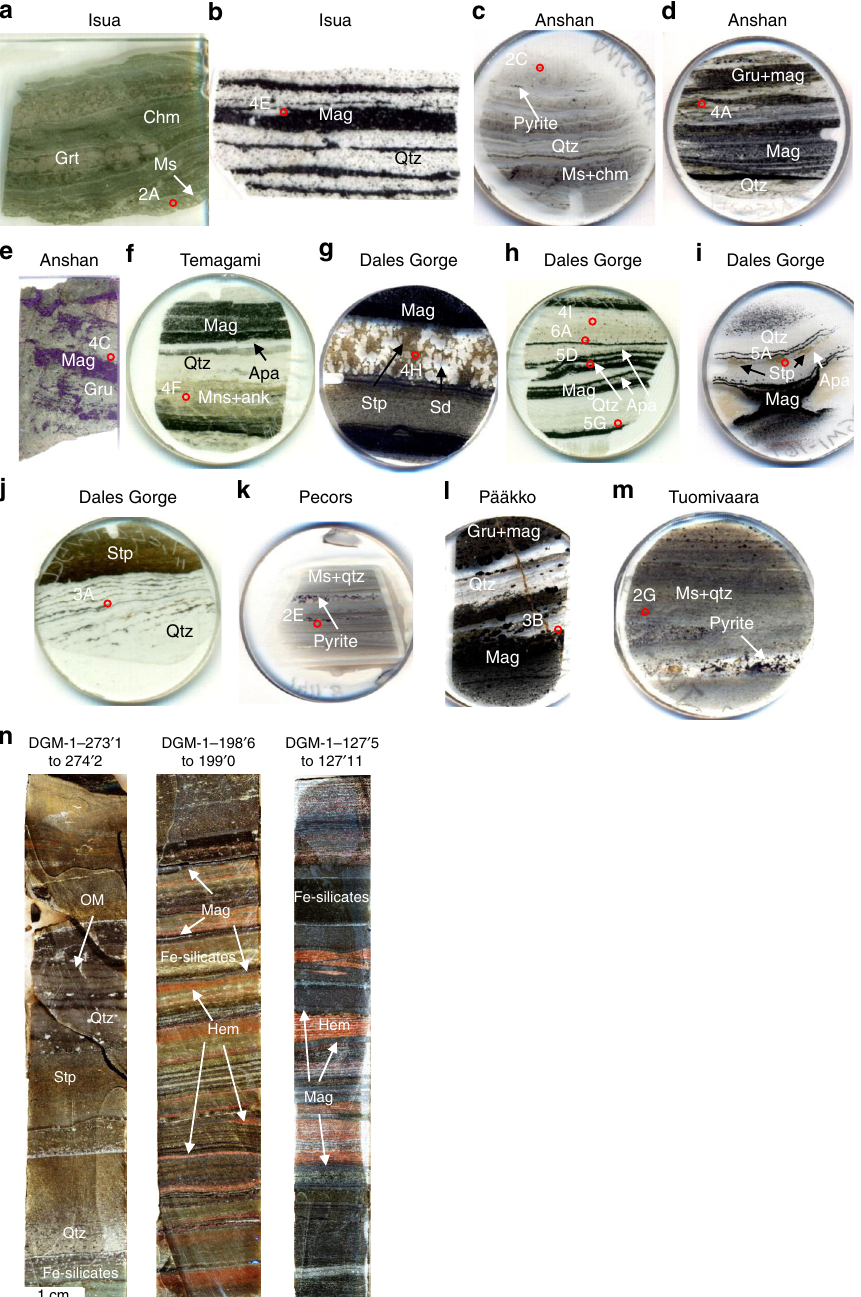
Fig. 1 Images of thin sections of samples used in this study. a Isua metapelite (GRDP0402). b Isua BIF (GRDP0404). c Anshan metapelite (ANS0904). d Anshan BIF (ANS0917). e Anshan BIF (ANS1507). f Temagami BIF (TE0704). g Dales Gorge BIF (DGM-1-57 ‘ 8 ” ). h Dales Gorge BIF (DGM-1-198 ’ 6 ” ). i Dales Gorge BIF (DGM-1-169'6 ” ). j Ferruginous chert, Dales Gorge section (DGM-1-273 ’ − 10 ” ). k Pecors metapelite (SM0175_1383.5). l Pääkkö sulphidic iron-formation (RPK344-156.4). m Tuomivaara metapelite (TU2-98.25). n Polished drill cores from the Brockman BIF, note the relative variability in mineralogy between core sections, representing variable depositional conditions. Numbered circles correspond to fi gure panels. Circle sections are 2.5 cm wide, rectangular sections are 8 cm long apart from the Isua section which is 4 cm long. Ank ankerite, Apa apatite, Chm chamosite, Gru grunerite, Grt grunerite, Mag magnetite, Ms muscovite, Qtz quartz, Sd siderite, Stp Bulk rock geochemical data for the Isua and published data for the Temagami BIF sample are − 4.6 ‰ and − 27.8 ‰ to − 32.8 ‰ the Anshan BIF are reported in Supplementary Table 4. respectively (Supplementary Table 2). Bulk rock geochemical data In the Temagami BIF, ankerite co-occurs with microscopic for the Temagami BIF are reported in Supplementary Table 4. particles of OM, yet the surrounding Fe-talc (minnesotaite) does Stilpnomelane (Supplementary Table 2) forms continuous not host any OM (Fig. 4f, g). OM also occurs in ankerite and parallel layers between magnetite bands in the Dales Gorge BIF. apatite intergrowths within an apatite-rich layer up to 600 The stilpnomelane layers are intermixed with lenses of Fe-talc, microns in thickness 13 . Bulk rock δ 13 C Carb and δ 13 C org values for and contain magnetite, apatite and ankerite inclusions (Fig. 4h, i).